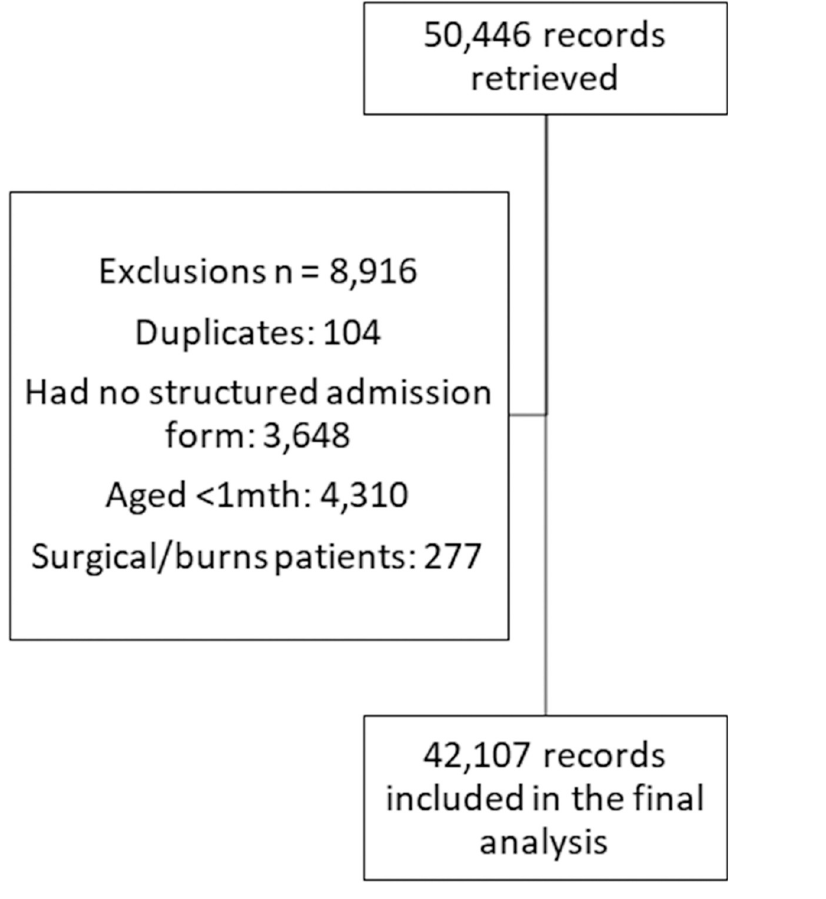
Fig 2. Flowchart of inclusion and exclusion